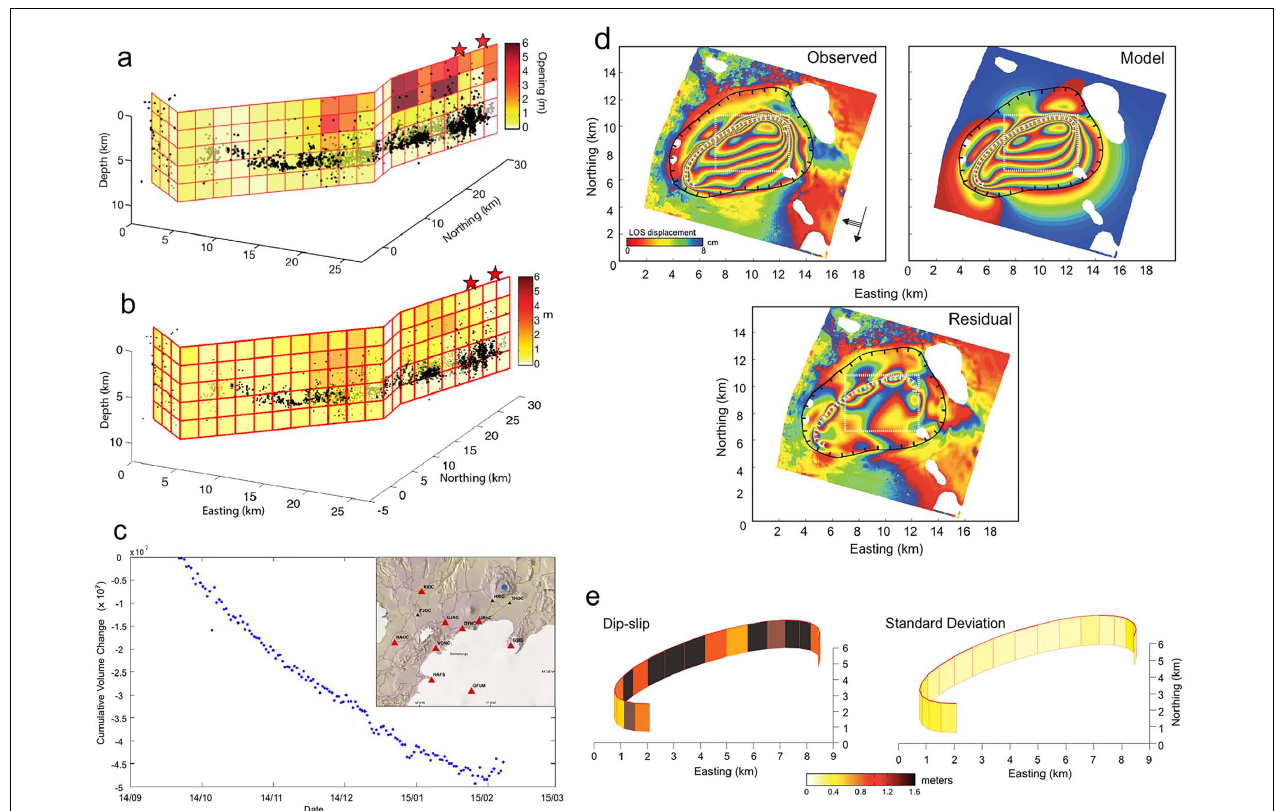
FIGURE 5 | Modeling of the rifting event and the caldera collapse. (a) Mean opening along the ∼ 50 km dyke that fed the Holuhraun eruption estimated using the MCMC approach and (b) associated standard deviation. Black dots represent the seismicity up to September 6, 2014. (a,b) Modified from Sigmundsson et al. (2015) with permission of SpringerNature. (c) Time series of the volume change for a point source like reservoir estimated from August 31 to February 15, 2015 using CGPS measurements shown in the inset (red triangles), assuming pressure change of a point source beneath the caldera. (d) Observed, predicted and residual surface displacements for deformation at the caldera associated with a Mw 5.3 earthquake on September 18, 2014. The black line outlines the outer caldera rim. The white lines mark the location of the inferred intra-caldera fault system (solid) and of the contracting body (dotted). (e) Median and standard deviation of the posteriori probability of dip-slip for fault segments inferred from modeling. Color indicates the magnitude of slip (key at the bottom). (d,e) Reproduced from Gudmundsson et al. (2016) with permission of AAAS.